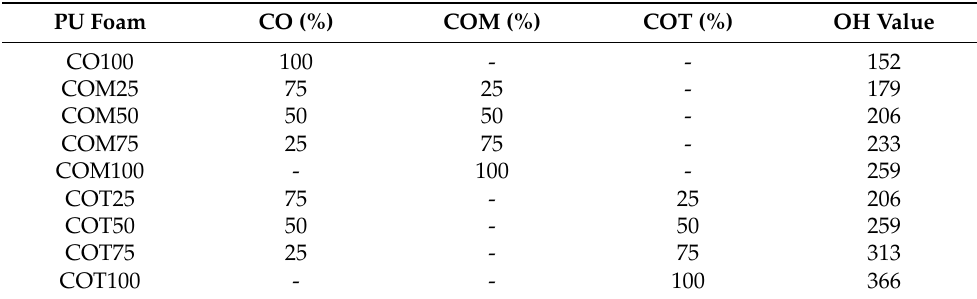
Table 2. Designation of synthesized PU foams and composition of polyol